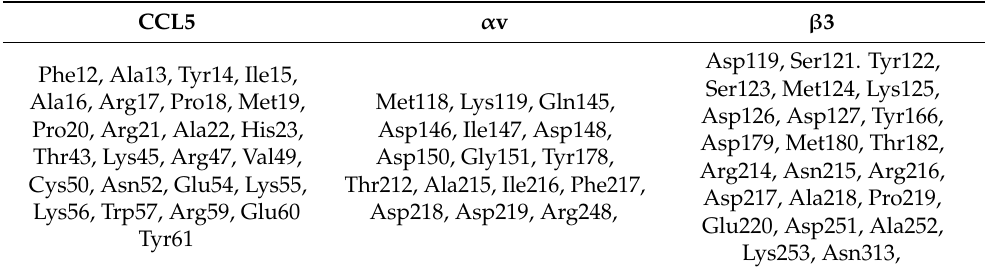
Table 2. Amino acid residues involved in CCL5 and α v β 3 (1JV2.pdb, closed headpiece) predicted by docking simulation. CCL5 α v β 3 Thr7, Thr8, Cys10, Phe12,